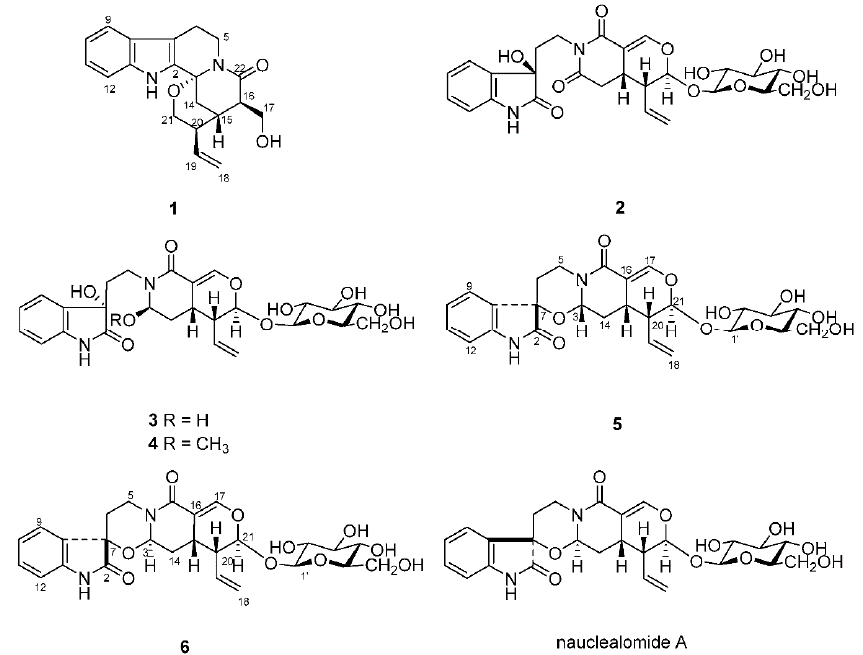
Figure 1. Structures of compounds 1 – 6 isolated from N . officinalis , as well as structure of nauclealomide A mentioned in the text.